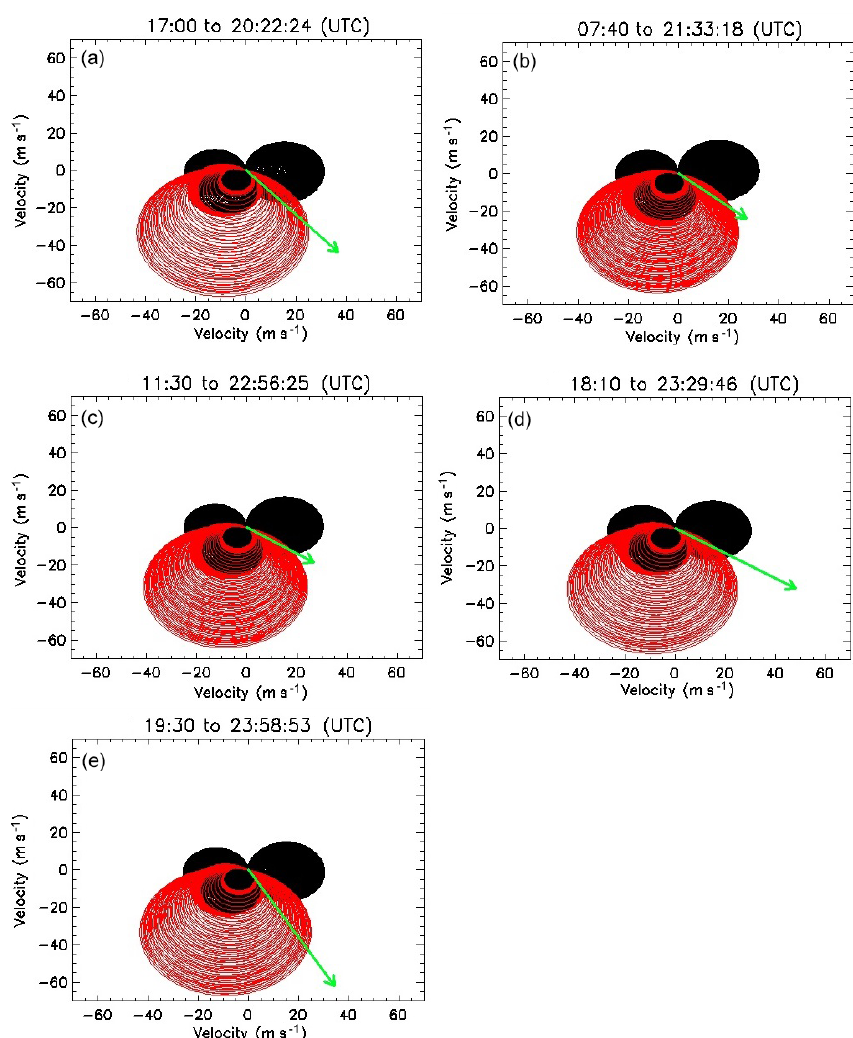
Figure 9. (a) Two-dimensional blocking diagrams for the GW 1 , (b) GW 2 , (c) GW 3 , (d) GW 4 , and (e) GW 5 events observed in the OH layer (87km). The green arrow depicts the magnitude and direction of the phase velocity of each GW. The red and black meshed regions represent the respective magnitude and the direction of the restricted area for the propagation of the wave to the (OH)